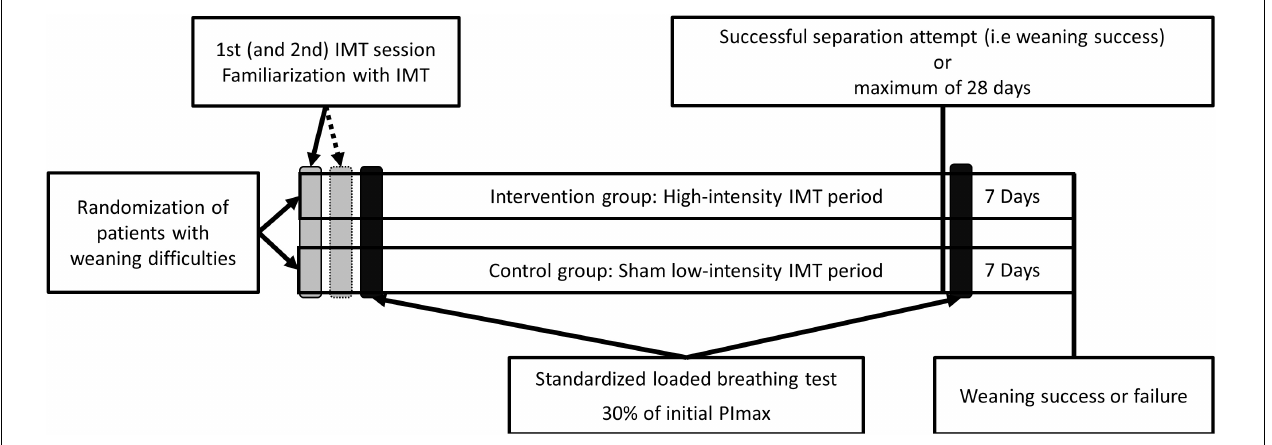
FIGURE 1 | Experimental design. After randomization patients were familiarized during one or two training sessions with the high-intensity inspiratory muscle training (IMT) or sham low-intensity IMT training protocol, in respect to the allocated training group. The subsequent day and the day after the successful separation attempt or after 28 days after inclusion, the patients in both groups performed a standardized loaded breathing task with an external load of approximately 30% of the maximal inspiratory pressure (PImax) of the patient at baseline. IMT was continued until weaning success or failure.